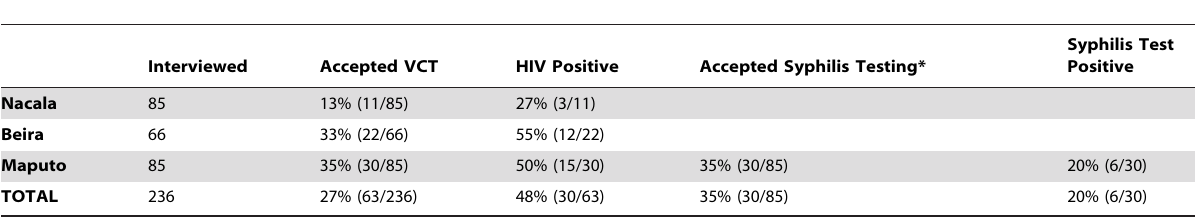
Table 3. Results of Voluntary Counseling and Testing (VCT) for HIV and Syphilis, Mozambique,